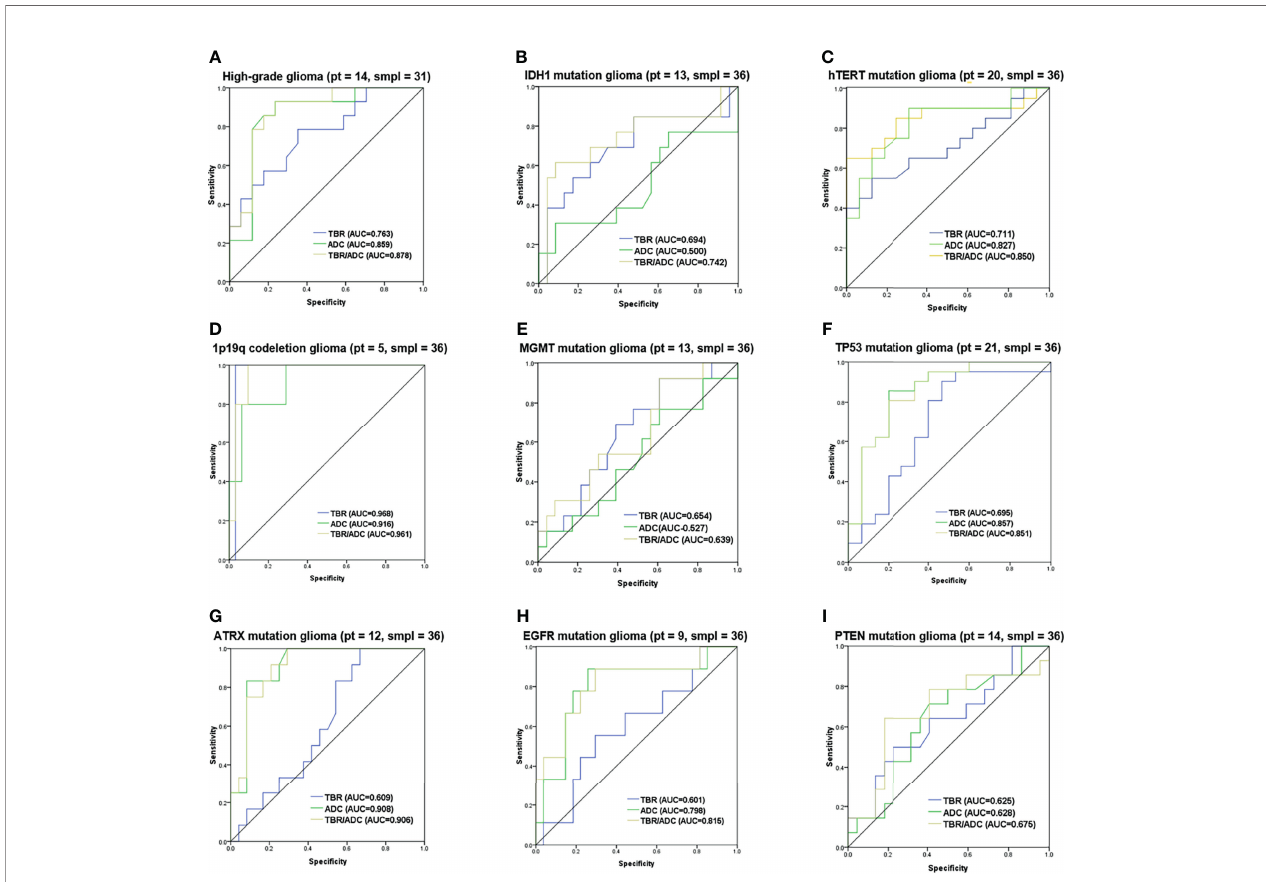
FIGURE 6 | Receiver operating characteristic curves of 18F-FET PET, and DWI imaging combination. ROC curves with the AUC of the optimal imagingcombinationsin yellow,FET-PET inblue and DWIin green in cyan for (A) grading, (B) IDH1 mutation, (C) hTERT mutation, (D) 1p/19q codeletion, (E) MGMT mutation, (F) TP53 mutation, (G) ATRX mutation, (H) EGFRmutation and (I) PTEN mutation. The number of patients and samples of each ROC analysis isdisplayed in the